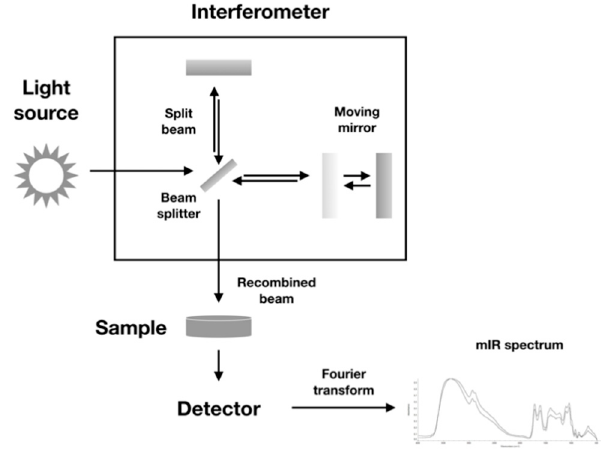
Figure 1. Schematic diagram of a typical FT-IR setup and a Michelson interferometer.